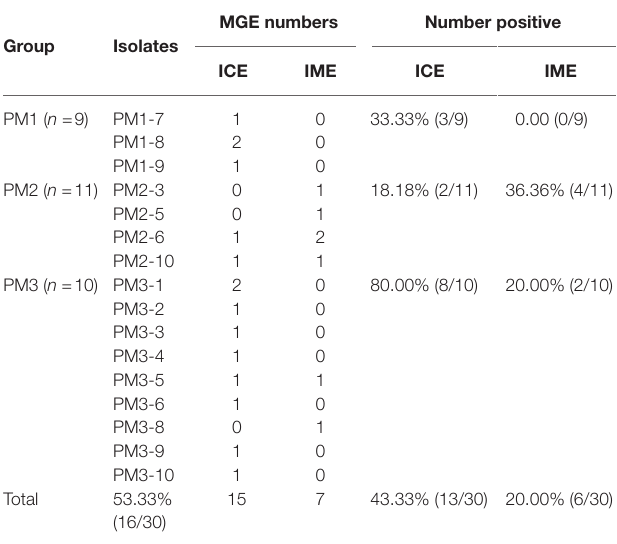
TABLE 4 | MGE prediction for the 30 isolates examined in this